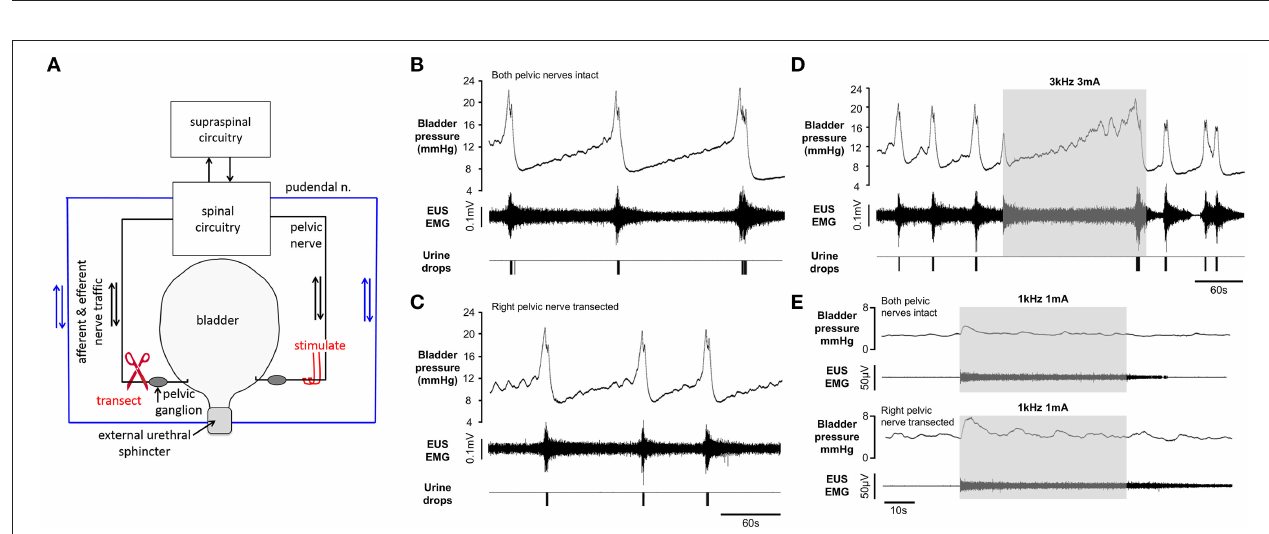
FIGURE 6 | Repeated voiding elicited by continuous infusion of saline into the bladder before (B) and after (C) unilateral transection of the preganglionic pelvic nerve (A) Non-voiding contractions during the filling phase were more prominent following transection of the nerve. (D) High frequency pelvic nerve stimulation (gray panel) blocked voiding after contralateral preganglionic pelvic nerve section. (E) Pelvic nerve stimulation during the filling phase evoked sustained tonic EMG activity and a transient “on-response” in bladder pressure before (upper traces) and after (lower traces contralateral pelvic nerve section.